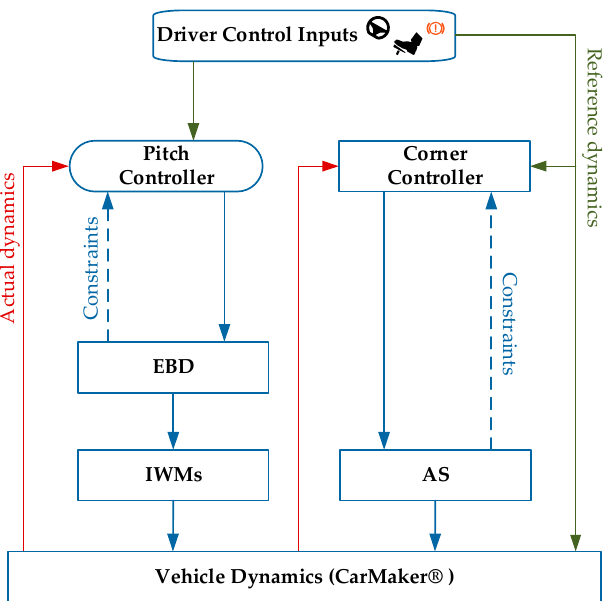
Figure 6. Ride blending control architecture. The control architecture features the in-wheel motors (IWMs) Pitch Controller serving the Electronic Brake Distribution (EBD) and the Corner Controller.